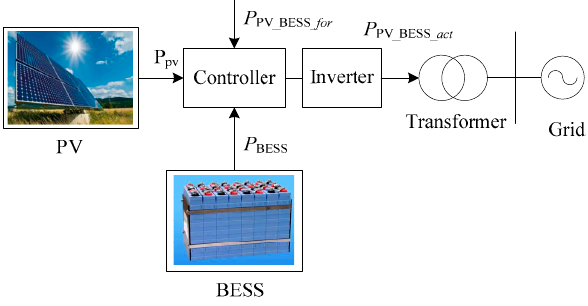
Figure 5. The system structure diagram of the PV-BESS power plant.